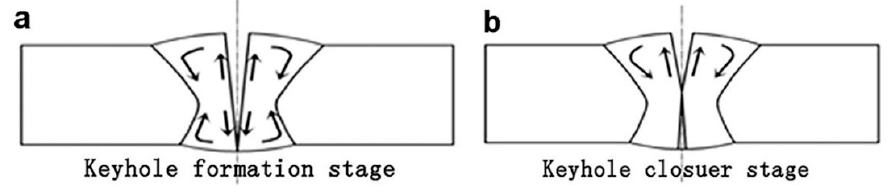
Figure 3. Molten pool flow process schematic.